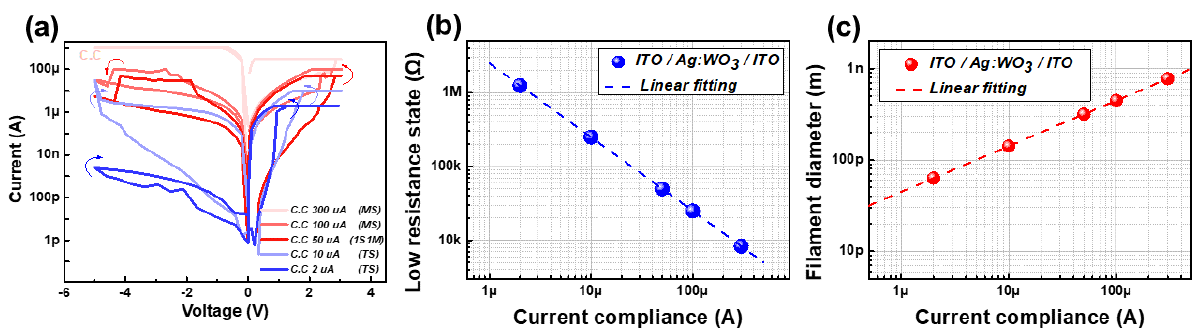
Figure 2. ( a ) Current versus voltage (I–V) curves at different current compliance values from 2 to 300 µ A. Various characteristics such as memory switching (MS), one selector with one memory (1S1M), and a threshold switch (TS) are dependent on the current compliance. ( b ) Resistance in the LRS at various current compliance values. ( c ) Derived filament size (diameter) with the current compliance from 2 to 300 µ